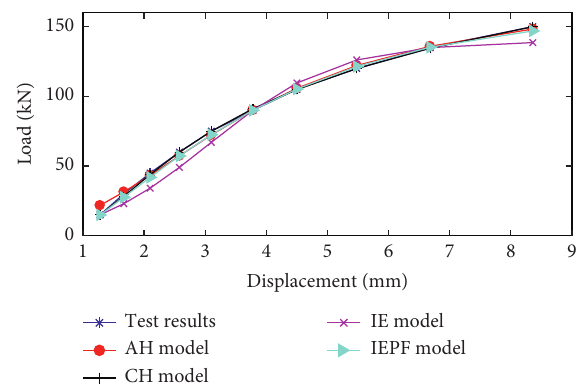
Figure 8: Comparison of each model with the test data from C